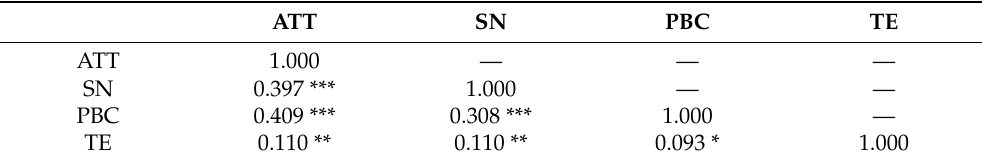
Table 7. Pearson correlation